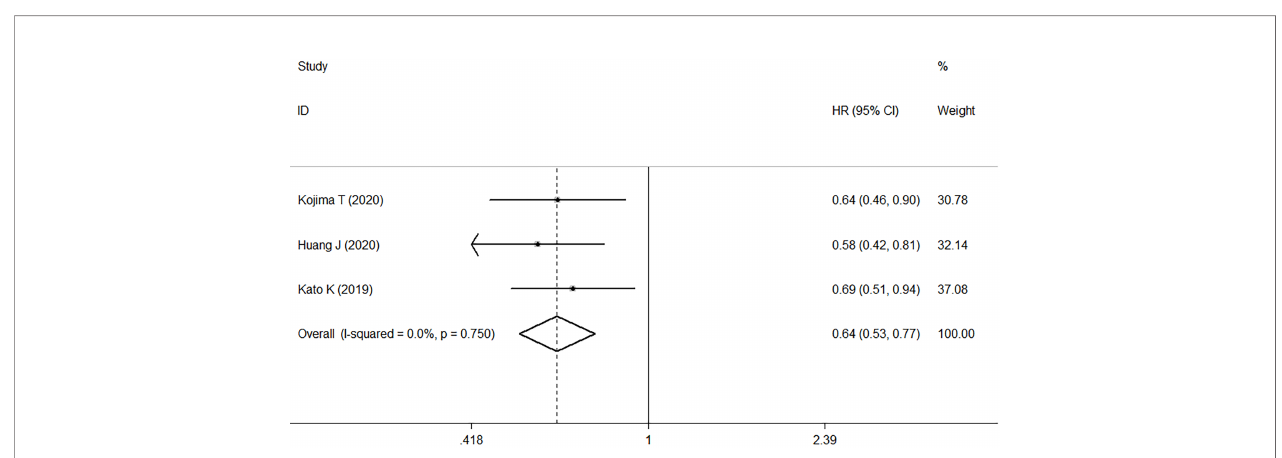
FIGURE 4 | Forest plots of HR comparing overall survival between patients with PD-L1-positive tumors treated with ICI treatment and chemotherapy. HR, hazard ratio; CI, con fi dence interval; ICI, immune checkpoint inhibitor.